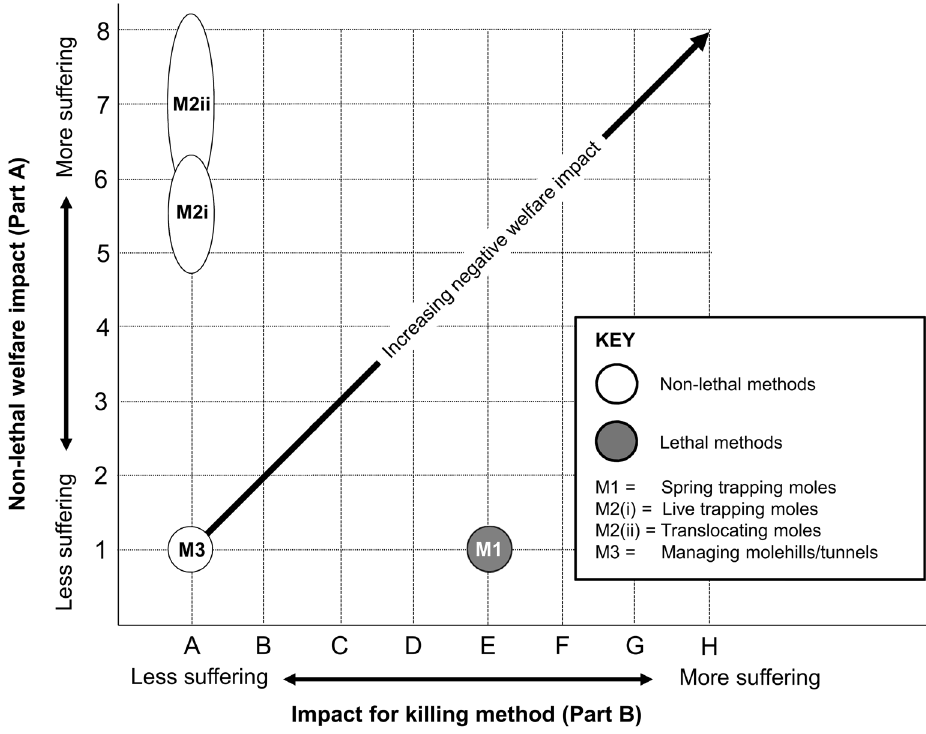
Fig 2. Welfare assessment grid for mole management